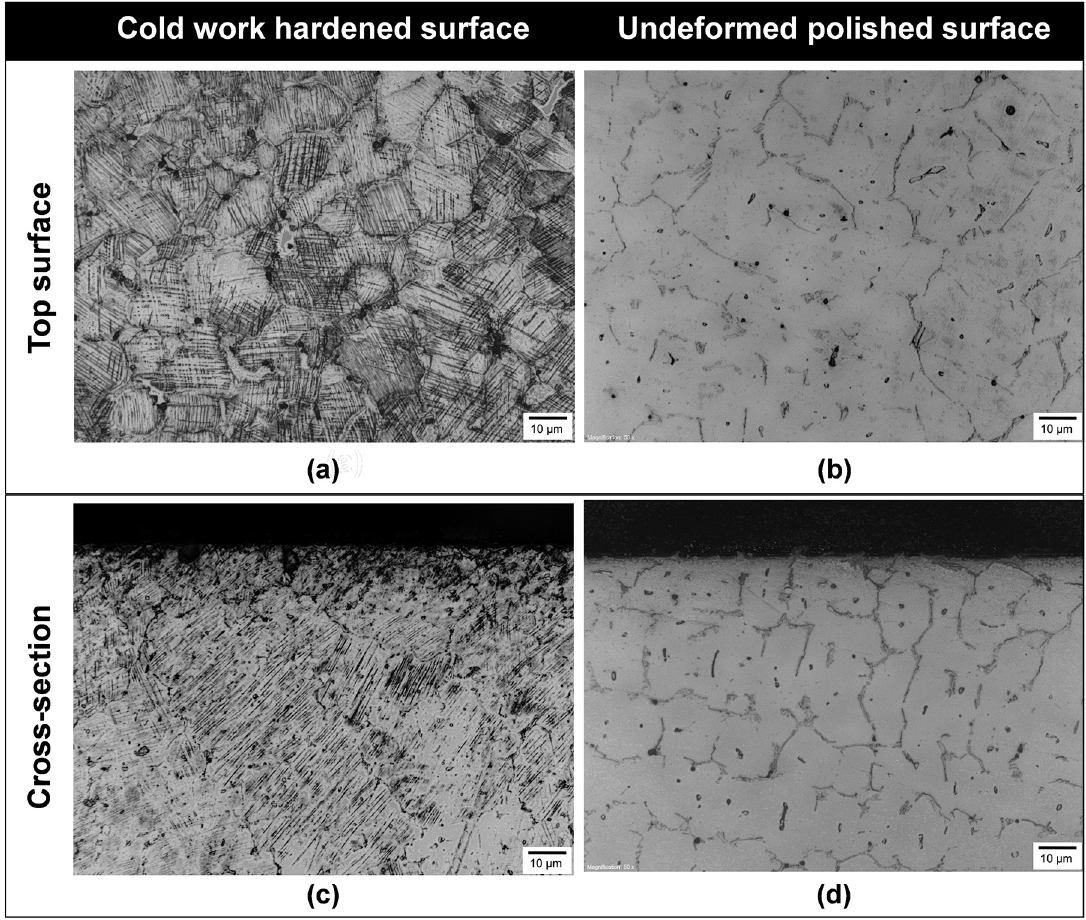
Figure 5: Presence of slip lines on top and cross-section of CWHS specimen, Fig. 5a and 5c, in contrast with its absence on the UPS specimen, Fig. 5b and 5d